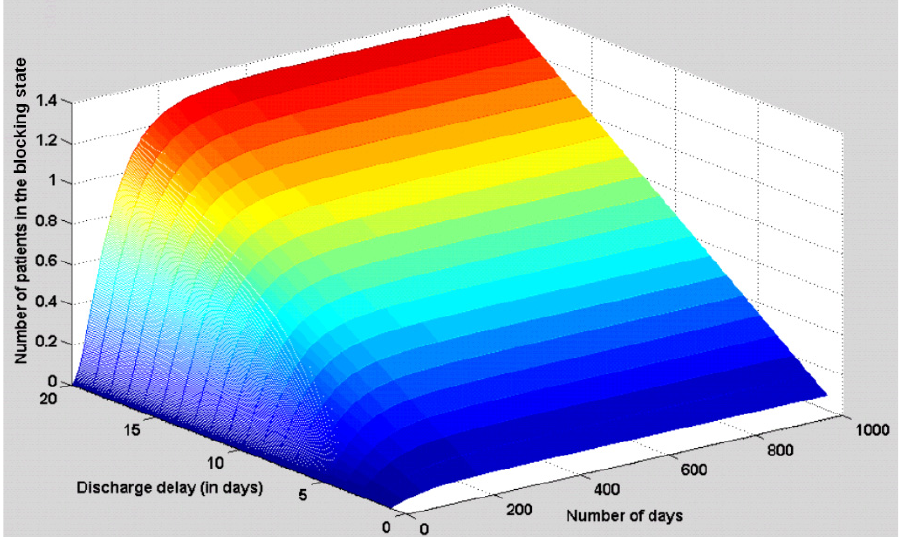
Figure 17. The number of patients (with respect to discharge delay) in the blocking state for discharge to private nursing homes.